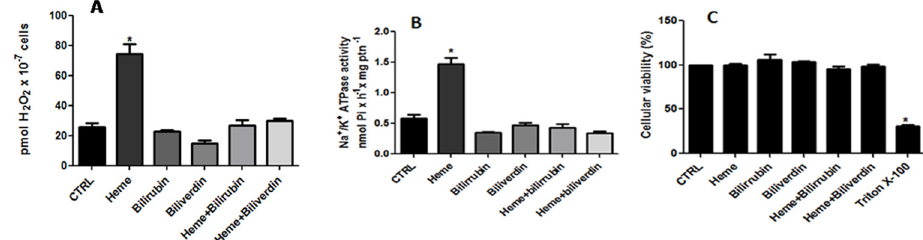
Fig 7. Effect of bilirubin and biliverdin on the production of hydrogen peroxide by L . amazonensis and in the Na + /K + ATPase activity of the parasite. Living parasites were incubated for 20 min in the reaction medium with the addition of 2.5 μ M bilirubin and 2.5 μ M biliverdin or bilirubin and biliverdin plus 2.5 μ M heme, as indicated on the abscissa. Hydrogen peroxide production (A), Na + /K + ATPase activity (B) and Cellular viability (C) were determinated. The values represent the mean ± standard error of at least three independent experiments. * Statistically significant when compared to control (P < 0.05). CTRL, control.